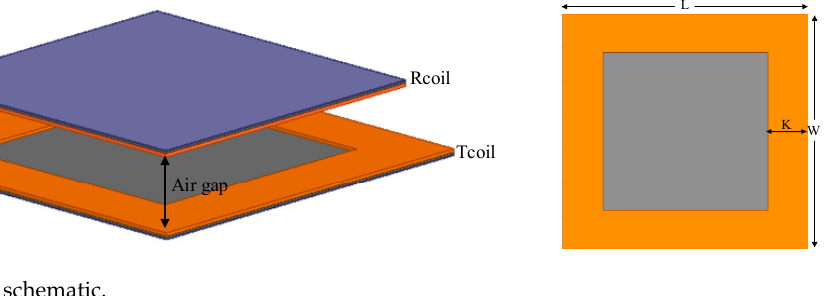
Figure 3. Coil schematic.